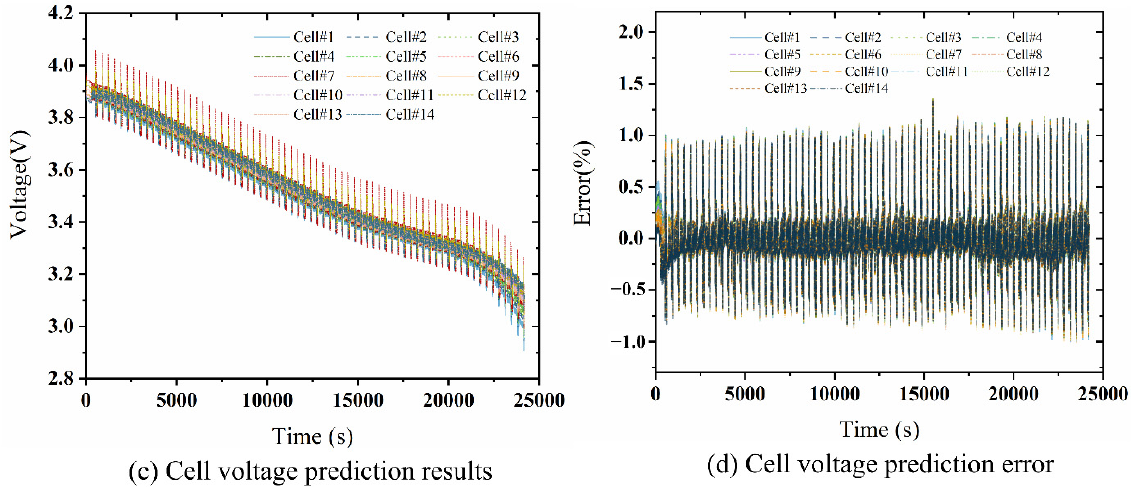
Figure 6. Voltage prediction on pack and cells in DST condition .